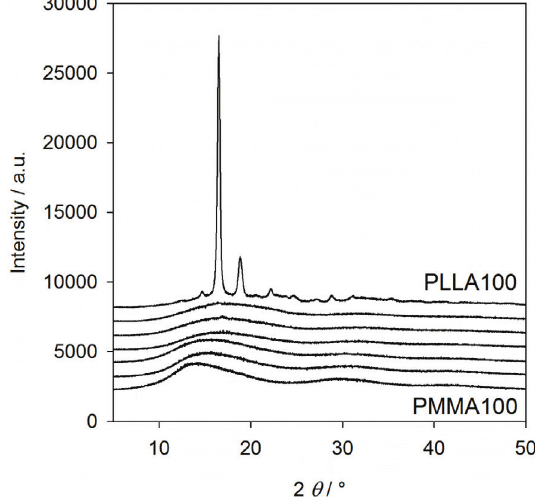
Fig. 5 – WAXD spectra of PLLA, PMMA, and PLLA/PMMA blends